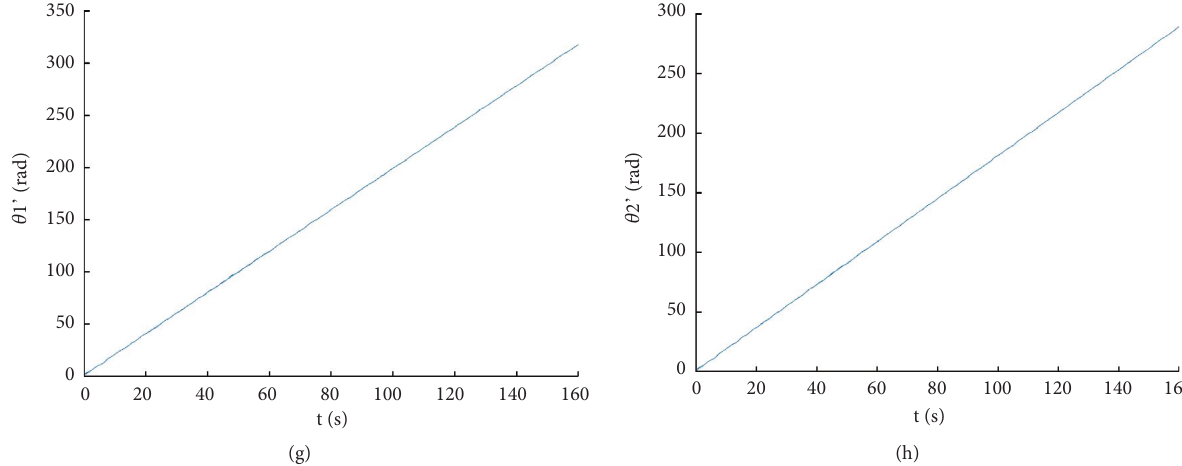
Figure 6: Curves of z ′ , and θ ′ changing with time. (a) The curve of z q , z 7 , z 6 , θ 1 , θ 2 , θ 3 , θ 1 2 with time. (c) The curve of z 6 changing with time. (d) The curve of θ 1 changing with time. (e) The curve of θ 2 changing with time. (f) The ′ changing with time. (h) The curve of θ curve of θ 3 changing with time. (g) The curve of θ 1